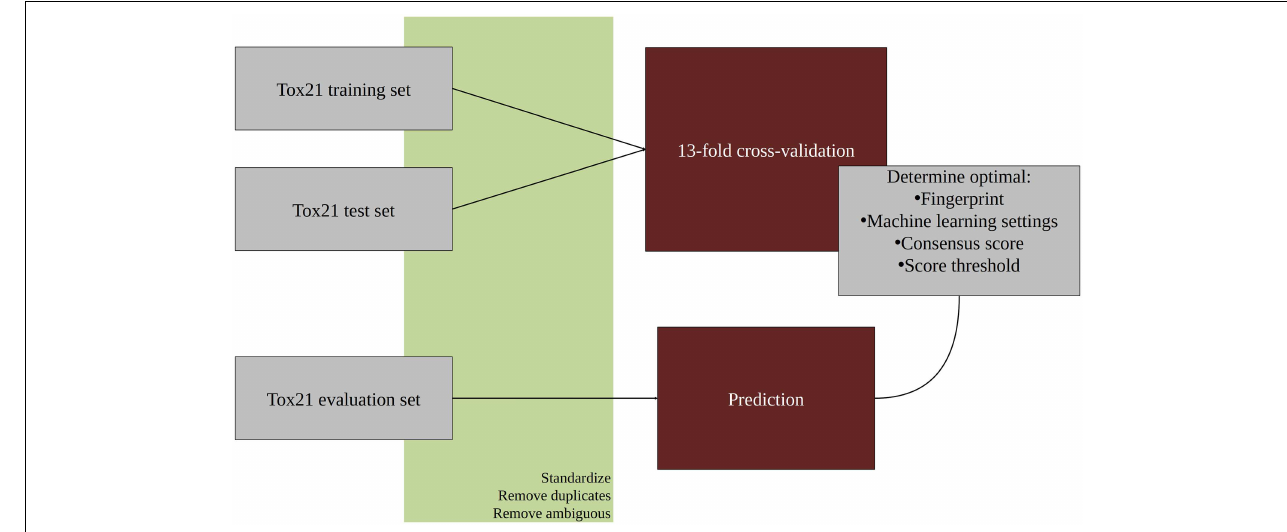
FIGURE 1 | Workflow